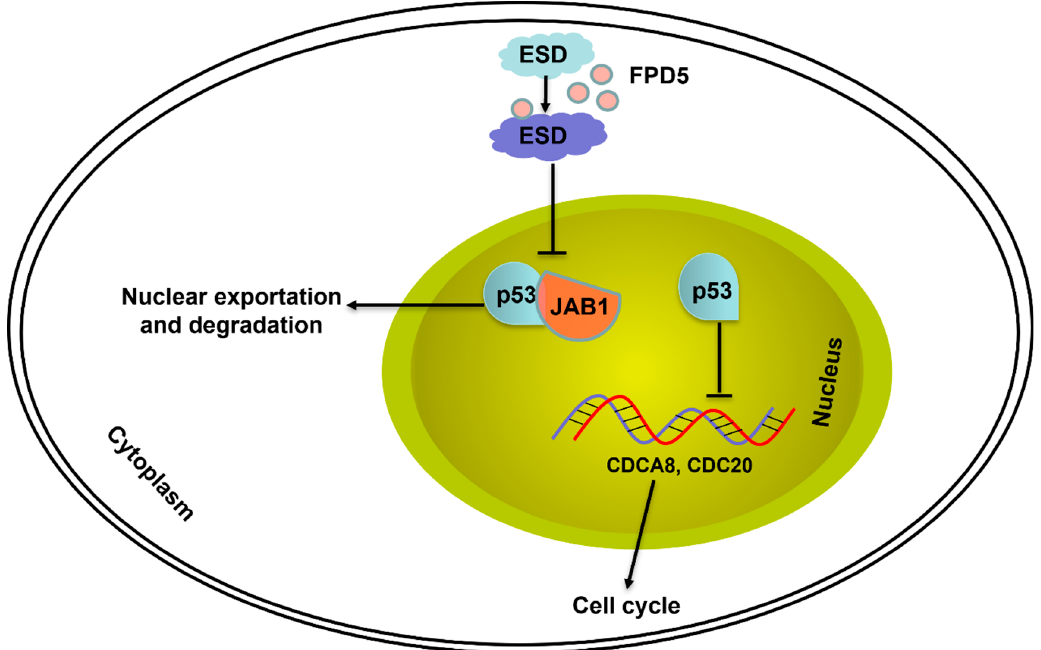
Figure 7. The mechanism of ESD inhibiting growth of A549 lung cancer cells. Activated ESD by FPD5 inhibited p53 to interact with JAB1, thereby reducing p53 exportation from nucleus to cytoplasm. p53 inhibited the expression of CDCA8 and CDC20 and thus arrested the cell cycle of A549 cells at G0/G1 phase and suppressed cell